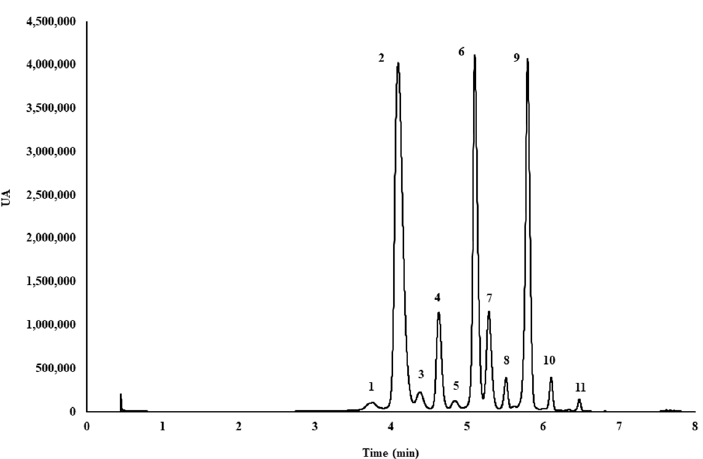
Figure 5. Ultra-high performance liquid chromatography (UHPLC) chromatogram of the eleven anthocyanins identified in the microwave-assisted extraction (MAE) extracts from myrtle berries.